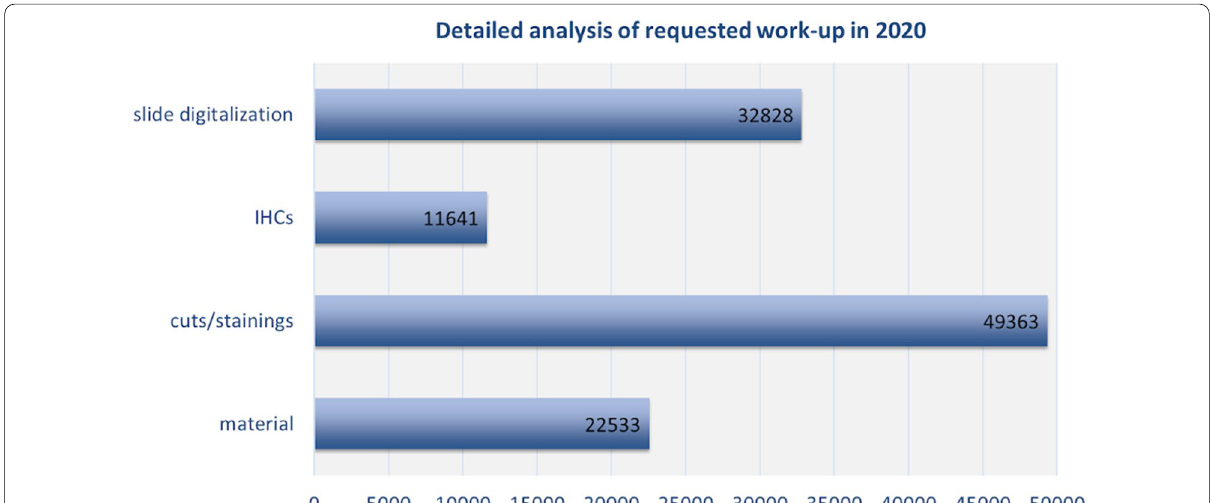
Fig. 1 Detailed analysis of the requested work-up in 2020 (material